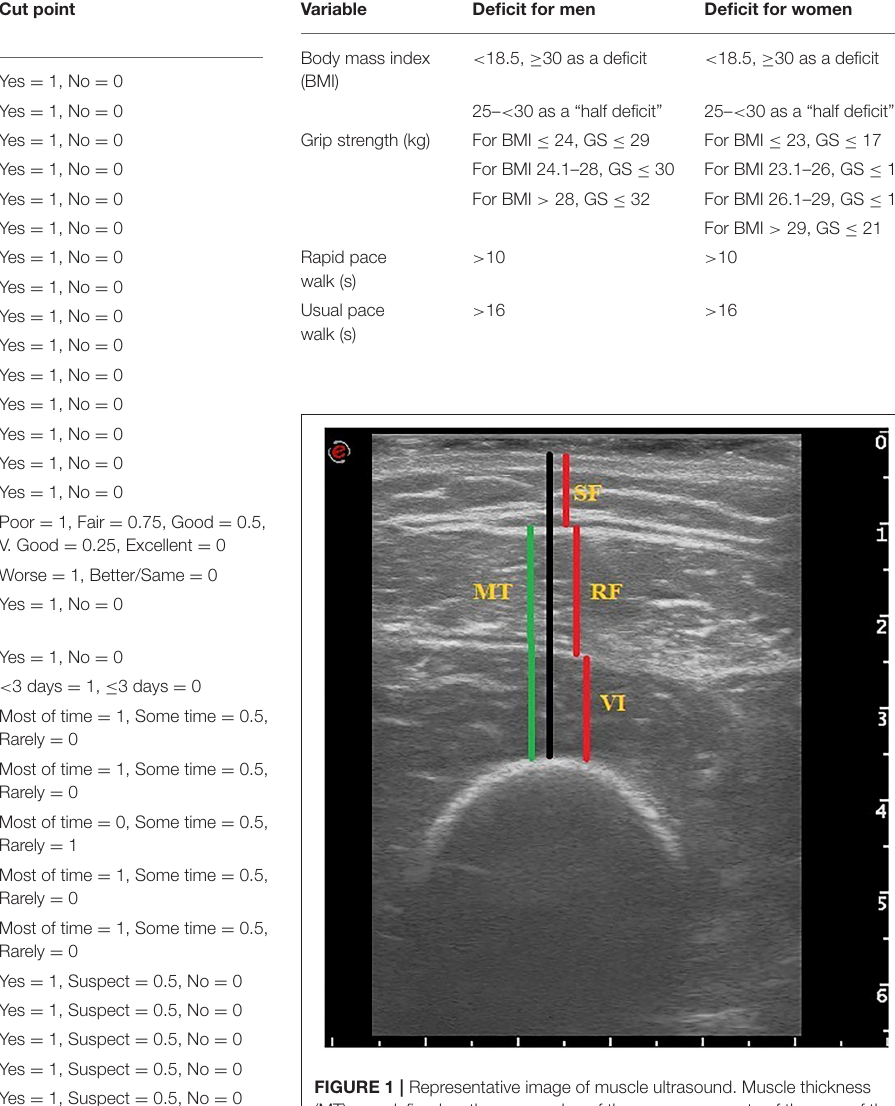
TABLE 1 | Health variables and cut-points for the frailty index – adapted from (9). List of variables included in the frailty index